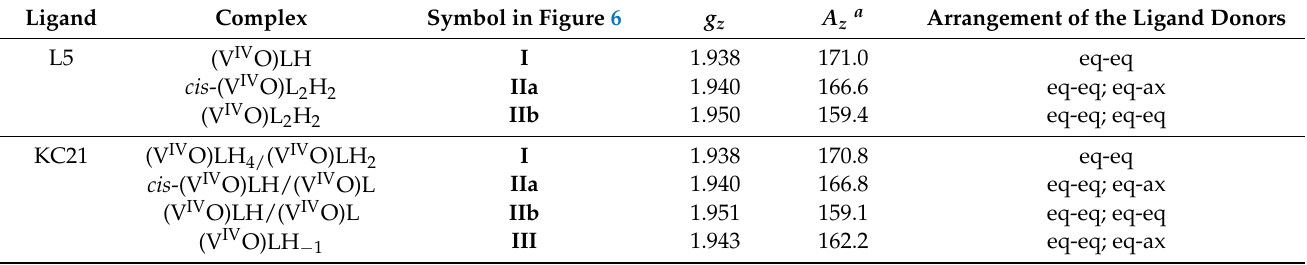
Table 3. EPR spin Hamiltonian parameters for V IV O 2+ complexes formed in aqueous solution by L5 and KC21.